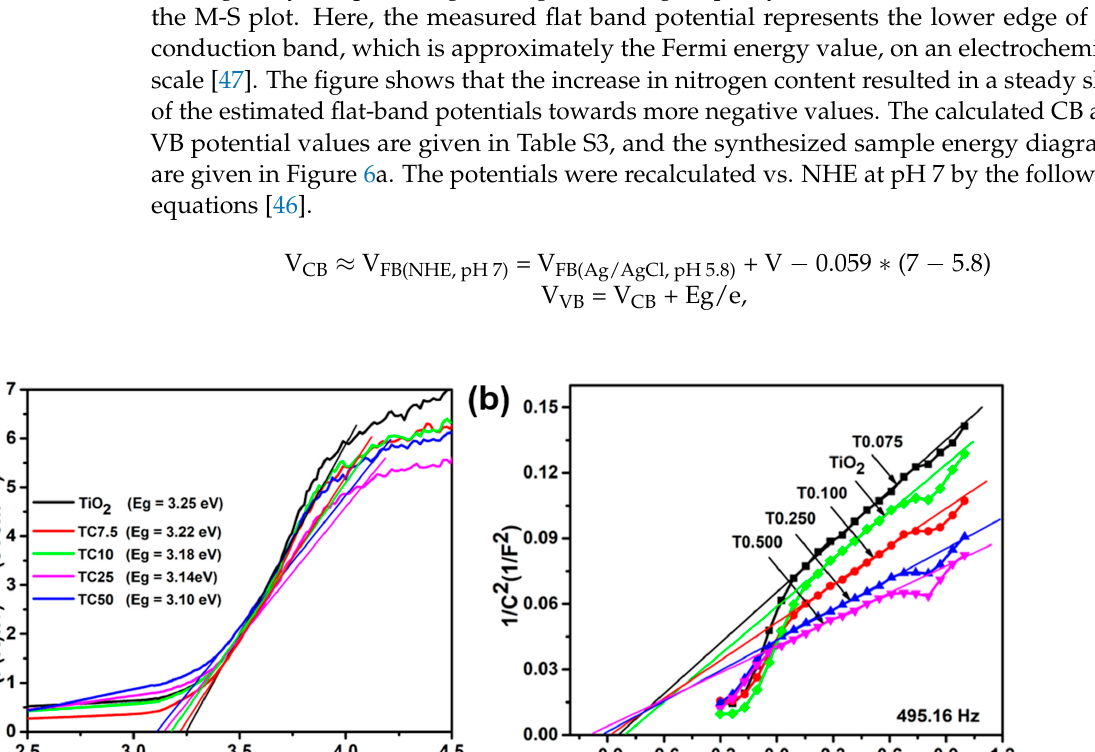
2 P25 and synthesized materials.